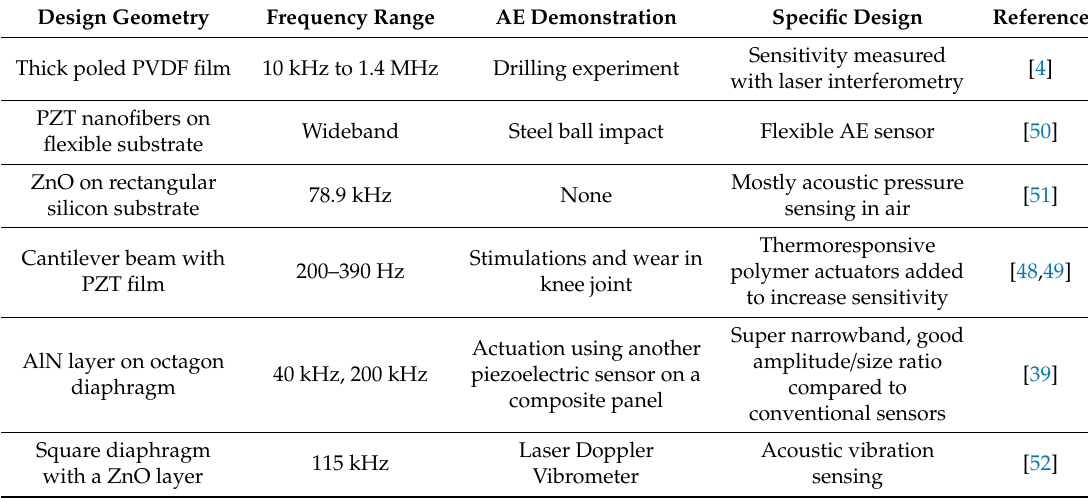
Table 4. Piezoelectric MEMS AE sensors and their